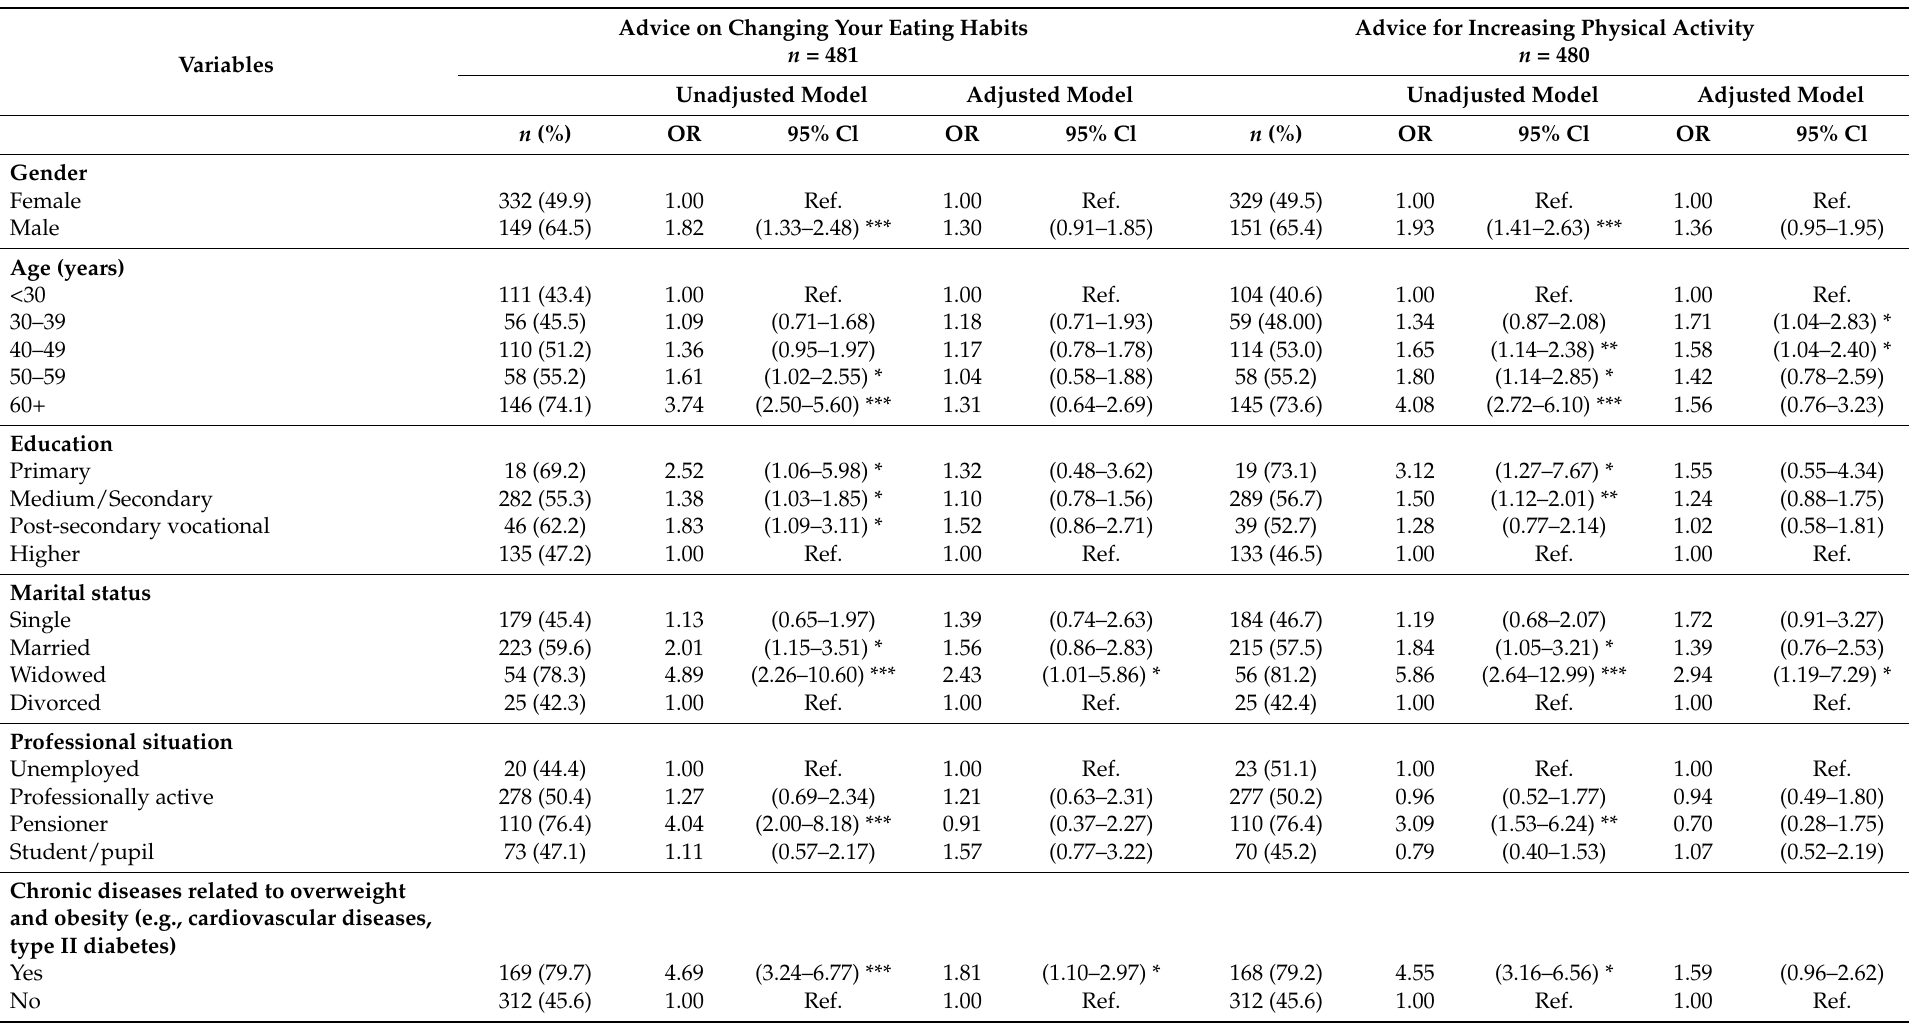
Table 3. The odds ratio of receiving advice from a primary care physician according to the analyzed